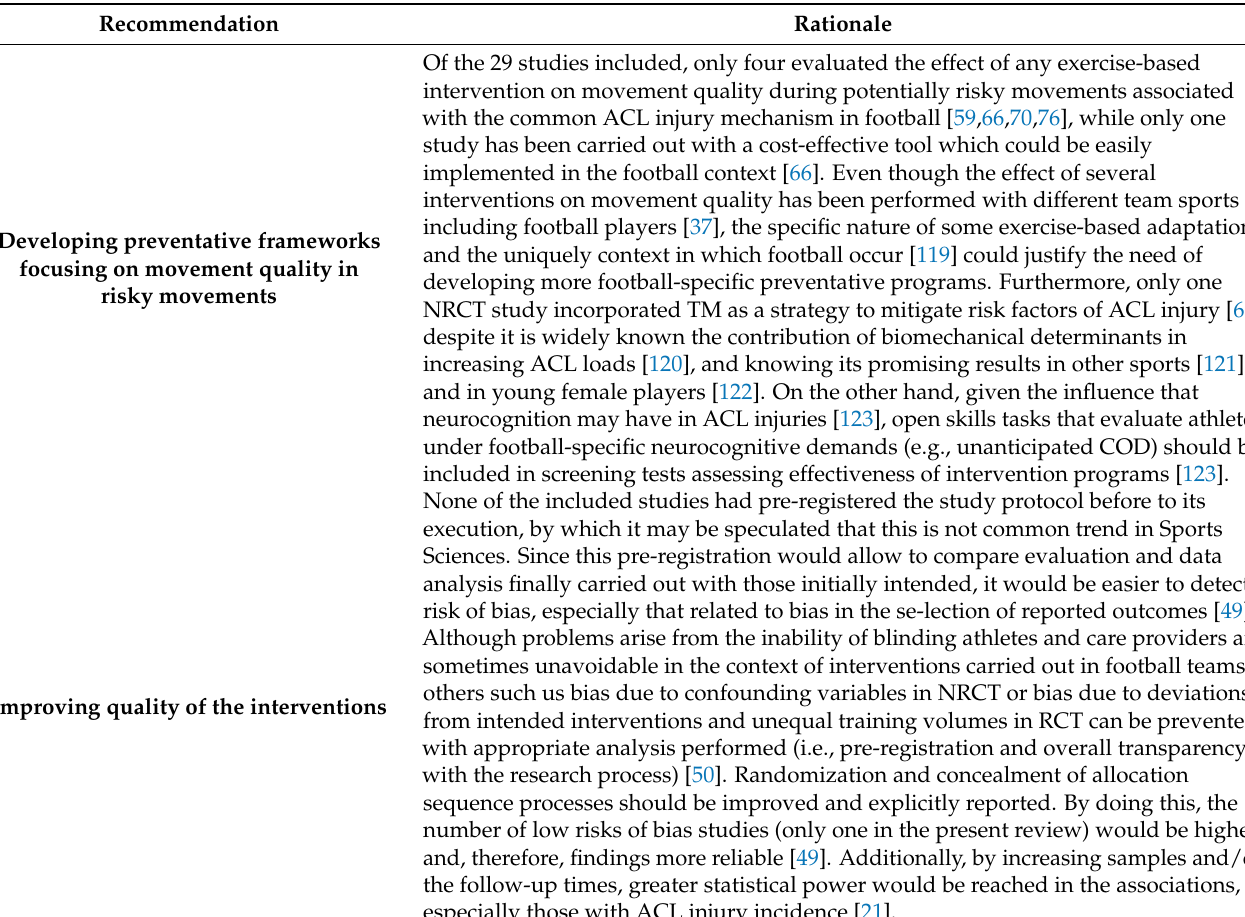
Table 6. Summary of considerations and recommendations for future